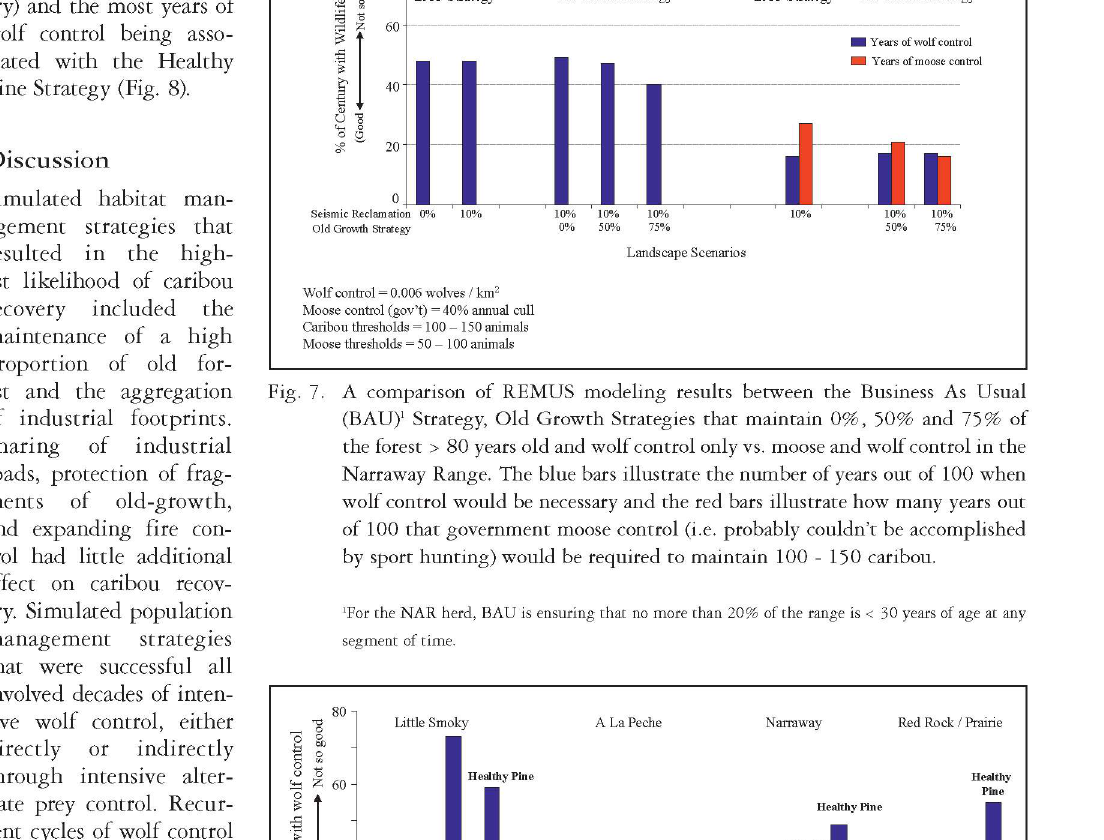
segment of time.